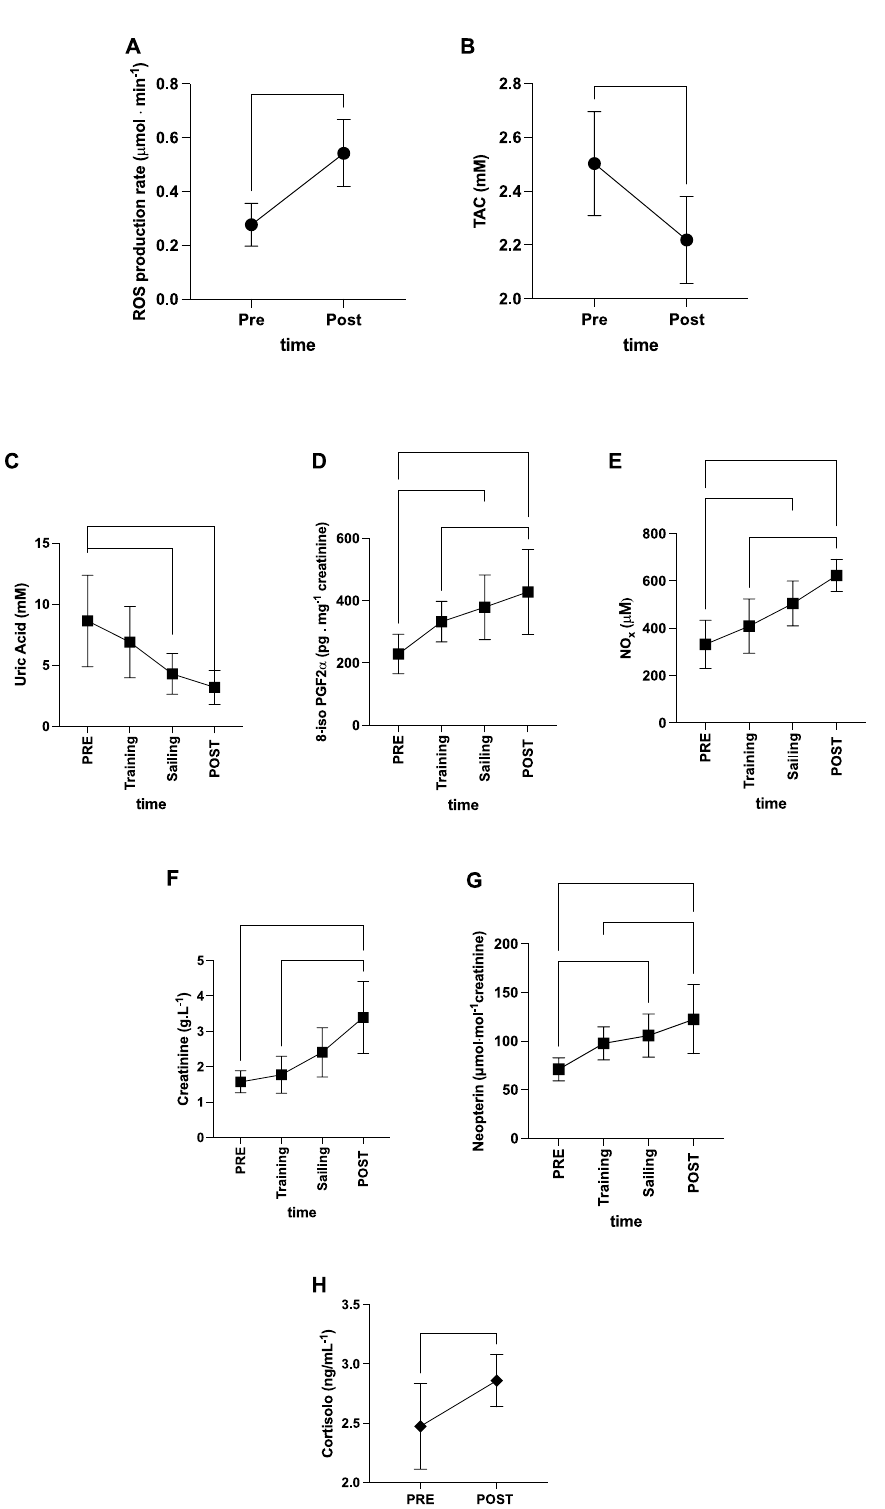
Figure 2. Biomarkers kinetic. Time course of: ( A ) radical oxygen species (ROS) production rate (μmol·min −1 ) and ( B ) total antioxidant capacity (TAC—mM) in saliva assessed by EPR; ( C ) uric acid (mM); ( D ) 8-isoprostane (8-iso-PGF2α, pg mg −1 creatinine); ( E ) nitric oxide metabolites (NOx, μM), ( F ) creatinine (g L −1 ), ( G ) neopterin (μmol mol −1 creatinine), concentrations detected in urine. In ( H ) cortisol levels (ng/mL) measured in saliva. *p < 0.05, **p < 0.01, ***p < 0.001 significantly different. Figure created with: GraphPad Prism, GraphPad Software inc. California, USA, version 9.0.1, https:// www. graph pad.